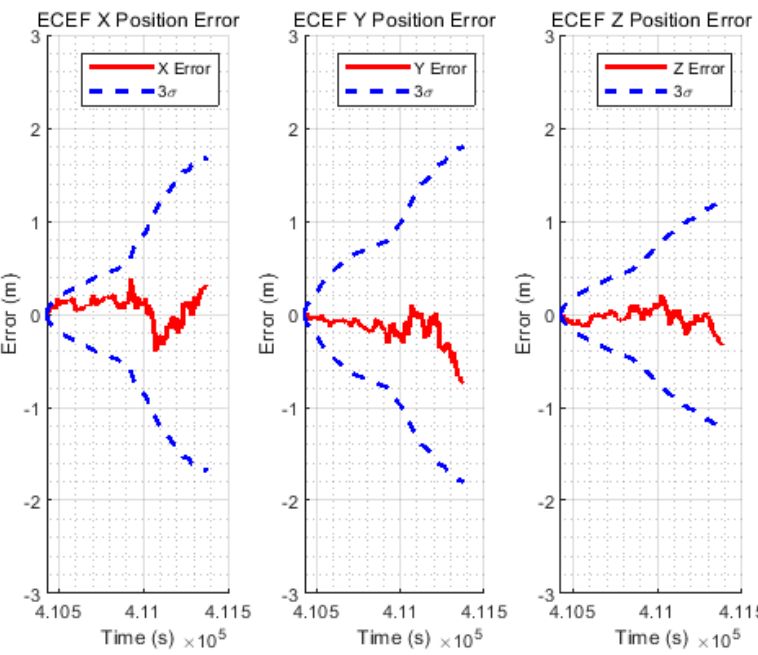
Figure 12. Time history of XYZ errors with 3 σ .